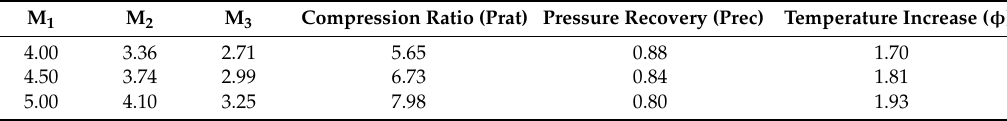
Table A1. Theoretical calculations for two ramp